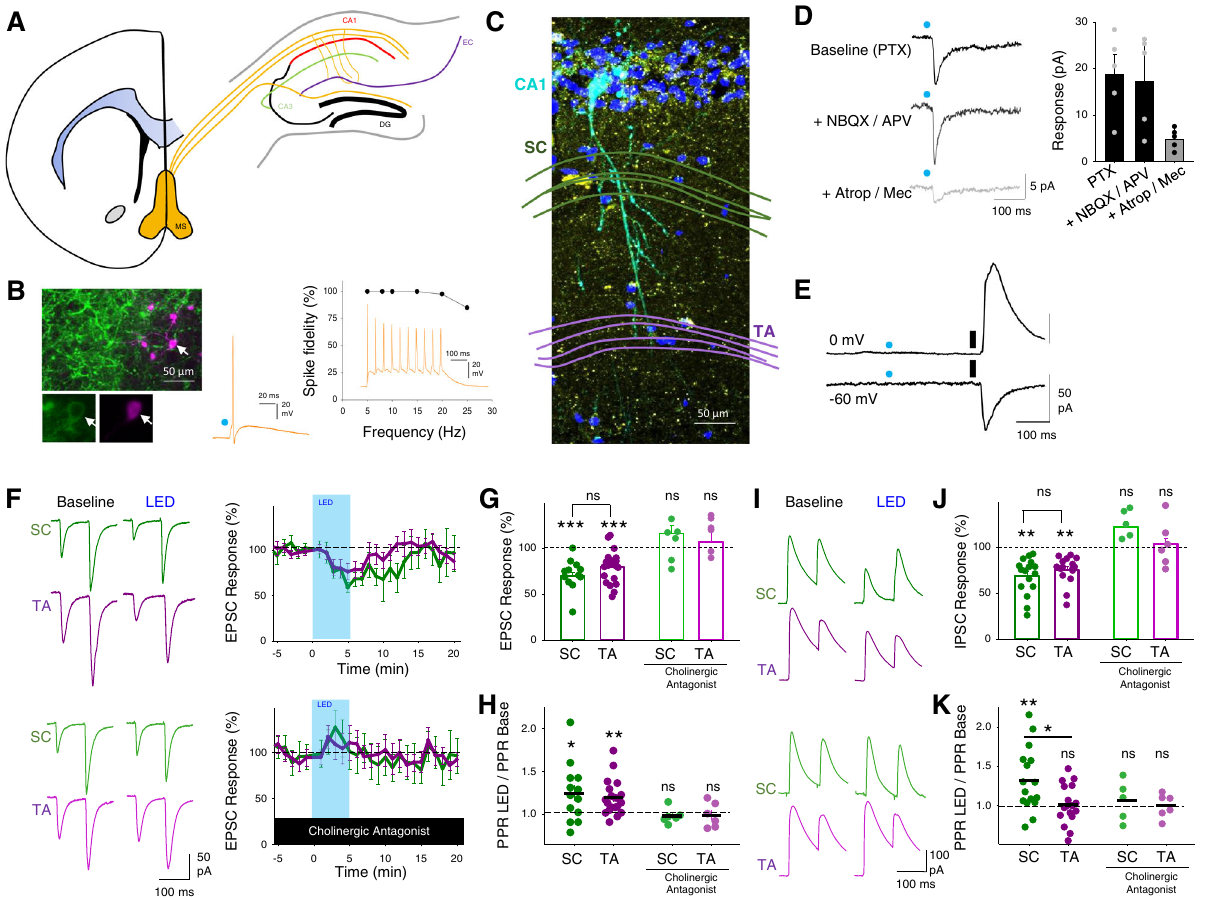
Fig. 1 Endogenous release of acetylcholine reduces excitatory and inhibitory synaptic inputs to CA1 pyramidal neurons. A Coronal section illustration of medial septum (MS, yellow) and its projections to dorsal hippocampus including Schaffer collateral (green) and temporoammonic (purple) inputs to CA1 from CA3 and entorhinal cortex (EC), respectively. B Example recording of ChR2-YFP expressing cholinergic neuron in medial septum. Left, immuno fl uorescence images showing cholinergic neuron (arrow) in medial septum fi lled with neurobiotin (purple) and expression of ChR2-YFP protein (green). Higher magni fi cation images below show ChR2-YFP on the membrane. Right, light-evoked stimulation of cholinergic neuron (blue dot, 10 ms) reliably elicits action potentials at frequencies <25 Hz. Representative example of four independent recordings. C Immuno fl uorescence of CA1 area of the hippocampus highlighting a CA1 pyramidal neuron fi lled with neurobiotin (light blue) and surrounding cholinergic axons (yellow). Nuclei stained with DAPI (dark blue) and location of Schaffer collateral (SC) and temporoammonic (TA) axons illustrated in green and purple, respectively. Representative example of 5 separate slice images. D Light stimulation of cholinergic fi bres (blue dot) elicits fast synaptic responses in Stratum Oriens interneurons recorded at − 60 mV that are sensitive to atropine (25 µ M) and mecamylamine (50 µ M) but not picrotoxin (PTX, 50 µ M), NBQX (20 µ M) or D-APV (25 µ M). E No response to light stimulation of cholinergic fi bres (blue dot) was seen in CA1 pyramidal neurons recorded at 0 mV or − 60 mV in contrast to electrical stimulation of SC axons (black line). F SC (green) and TA (purple) evoked EPSCs in CA1 pyramidal neurons are reversibly depressed by 2 Hz light stimulation (LED) of cholinergic fi bres for 5 minutes (top). The depression of EPSCs is blocked by the application of cholinergic antagonists atropine (25 µ M) and mecamylamine (50 µ M) (Bottom). G , H Acetylcholine release depressed SC and TA pathway-evoked EPSCs (G; SC pathway, n = 12 from 6 mice, p = 0.0002; TA pathway, n = 20 from 9 mice, p = 0.0002; SC – TA comparison, p = 0.46) and increased paired-pulse ratio (H, PPR; SC pathway, p = 0.021; TA pathway, p = 0.008; SC – TA comparison, p = 0.52). Nicotinic and muscarinic receptor antagonists atropine (25 µ M) and mecamylamine (50 µ M) blocked the effects of acetylcholine release on EPSCs (SC pathway, n = 6 from 3 mice, p = 0.73; TA pathway, n = 6 from 3 mice, p = 0.75) and PPR (SC pathway, p = 0.86; TA pathway, p = 0.61). I Feedforward disynaptic IPSCs evoked by stimulation of SC and TA pathways are depressed by light stimulation of cholinergic fi bres (top). The depression of IPSCs is blocked by the application of cholinergic antagonists atropine and mecamylamine (bottom). J , K Effects of acetylcholine release on SC and TA pathway-evoked IPSC response ( J SC pathway, n = 16 from 10 mice, p = 0.001; TA pathway, n = 16 from 11 mice, p = 0.009; SC – TA comparison, p = 0.28) and PPR ( K SC pathway, p = 0.006; TA pathway, p = 0.75; SC – TA comparison, p = 0.011). Cholinergic receptor antagonists blocked the effects of acetylcholine release on IPSCs (SC pathway, n = 5 from 4 mice, p = 0.17; TA pathway, n = 6 from 4 mice, p = 0.26) and PPR (SC pathway, p = 0.64; TA pathway, p = 0.95). Data are mean ± SEM; inter-group comparisons one-way ANOVA with post hoc Bonferroni correction. Within-group comparisons two-tailed paired t -test *** p < 0.001 ** p < 0.01 * p < 0.05. Source data are provided as a Source Data fi le.